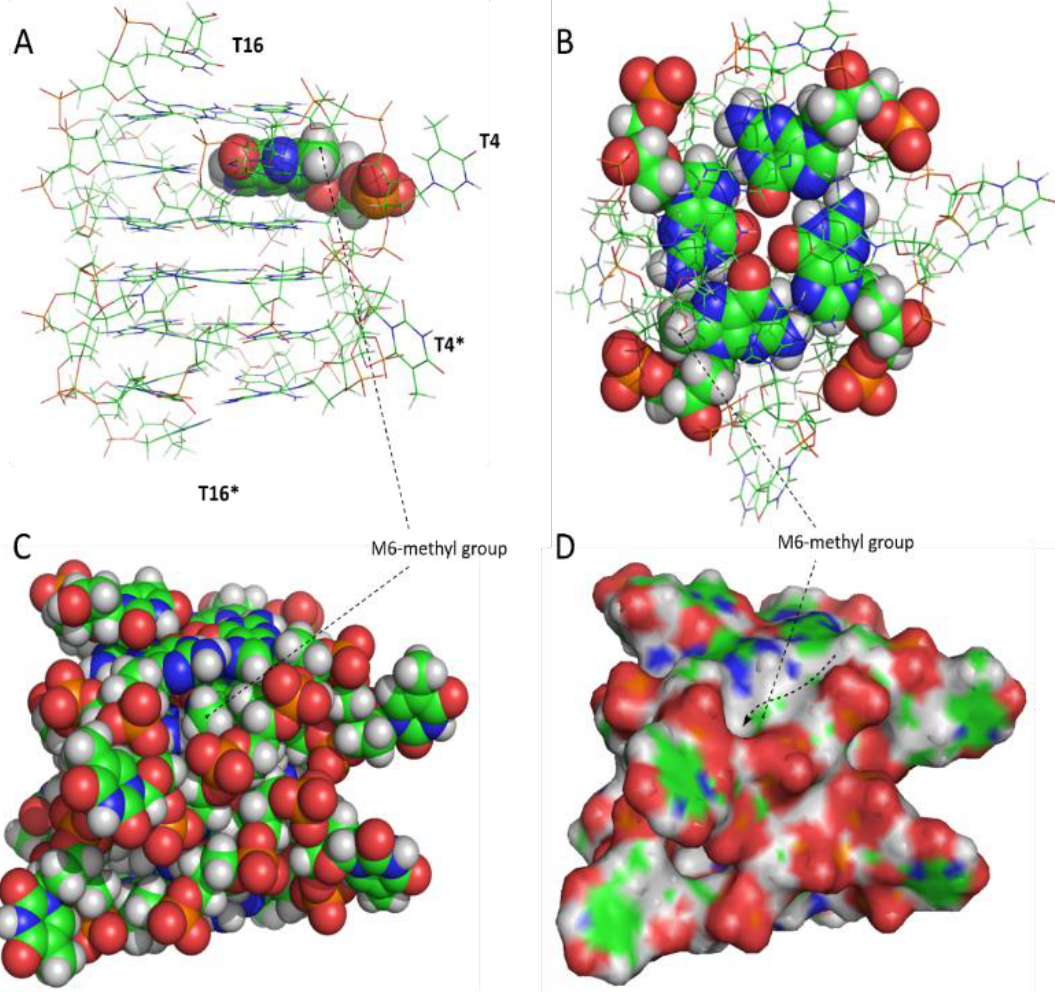
Figure 5. G-quadruplex structure adopted by INT-M6. ( A ) Side view of the stick model. The M-residue is reported in CPK. ( B ) Top view of the stick model. The central G-tetrad is in CPK. ( C ) Side view of the CPK model. ( D ) Side view of the surface model. The dashed line with an arrow indicates the groove in which the methyl group is positioned. Heavy atoms are shown with different colors (carbons, green; nitrogens, blue; oxygens, red; hydrogens, white; phosphorus, orange).